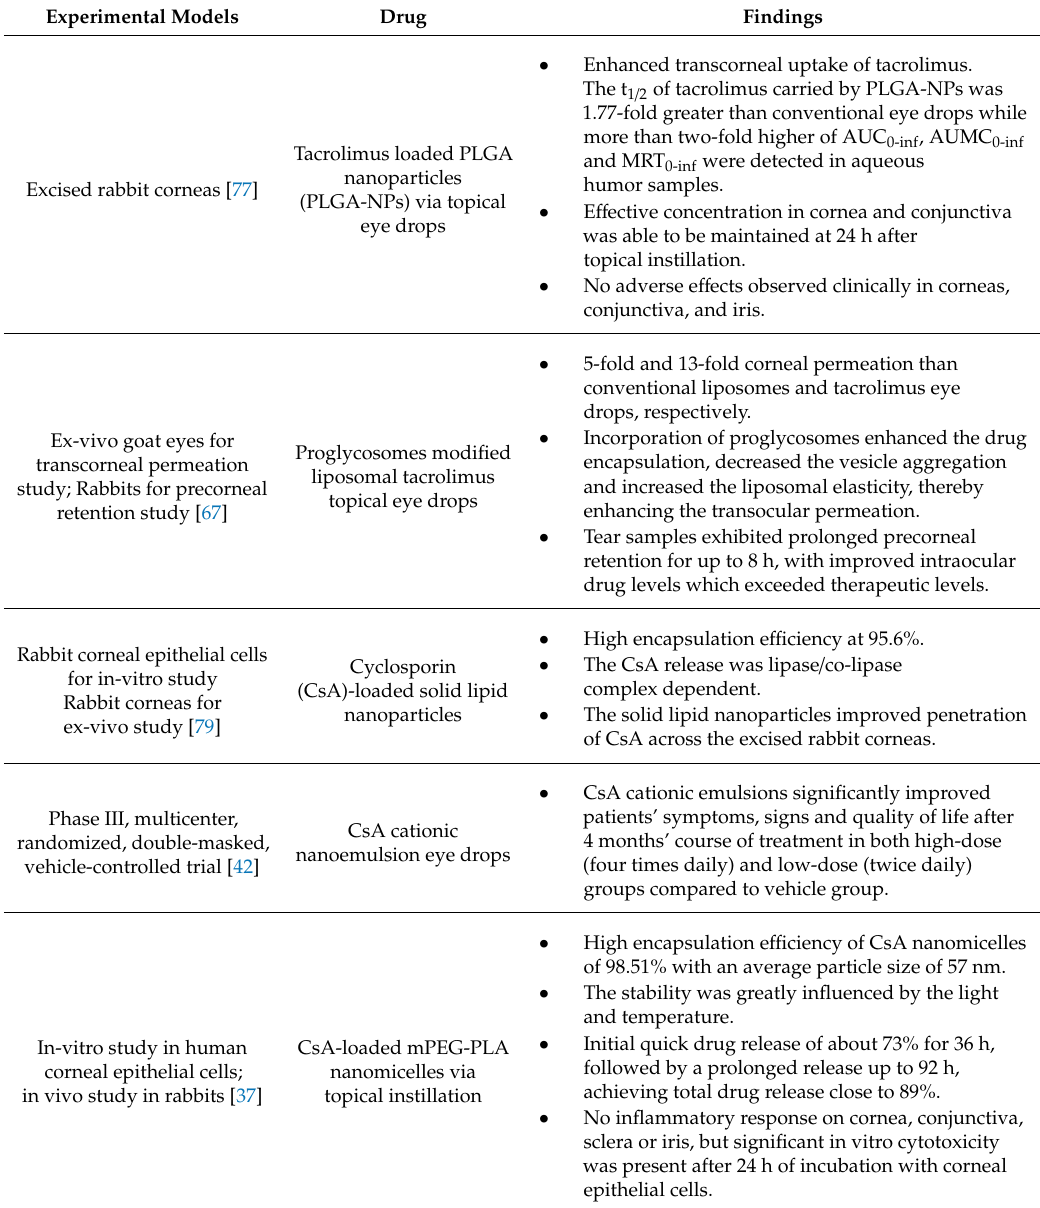
Immunomodulatory agents using nanotechnology-based drug delivery systems for allergic